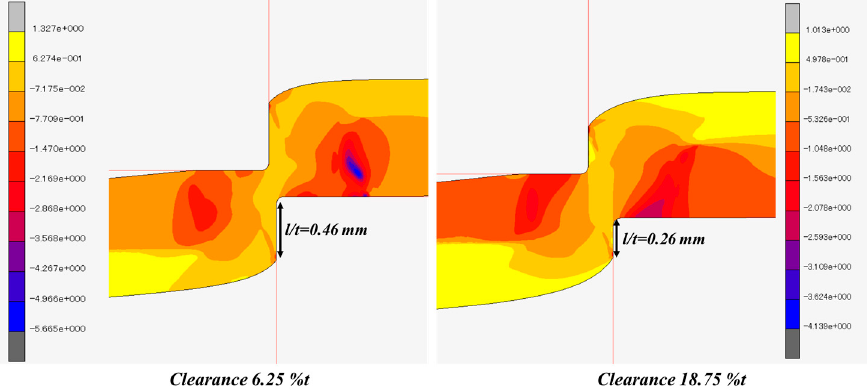
Figure 10. The distribution of stress triaxiality at the different fracture initiation point for the blank thickness of 1.6 mm, punch diameter of 10 mm, and clearances of 6.25 %t and 18.75 %t.